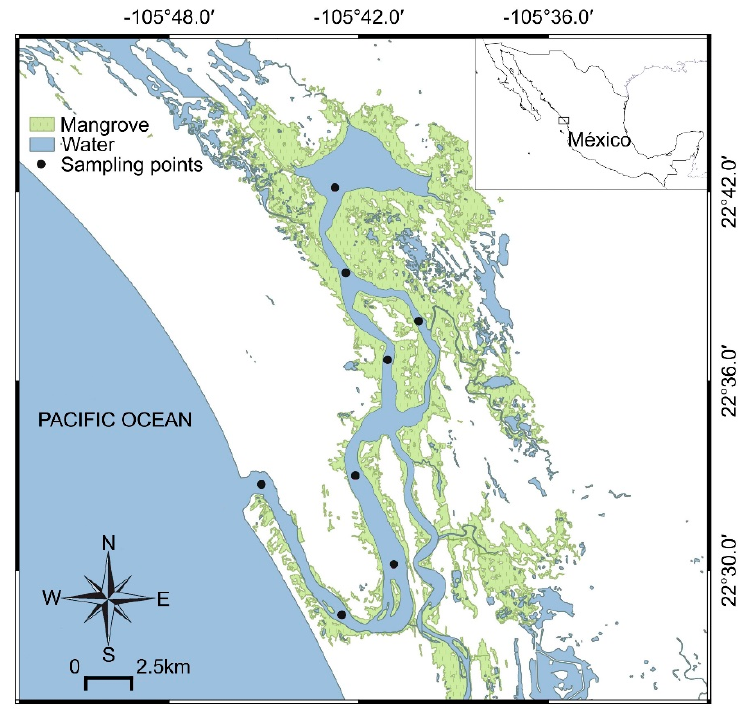
Figure 1. Map of the studied area. Black dots indicate sampling stations.